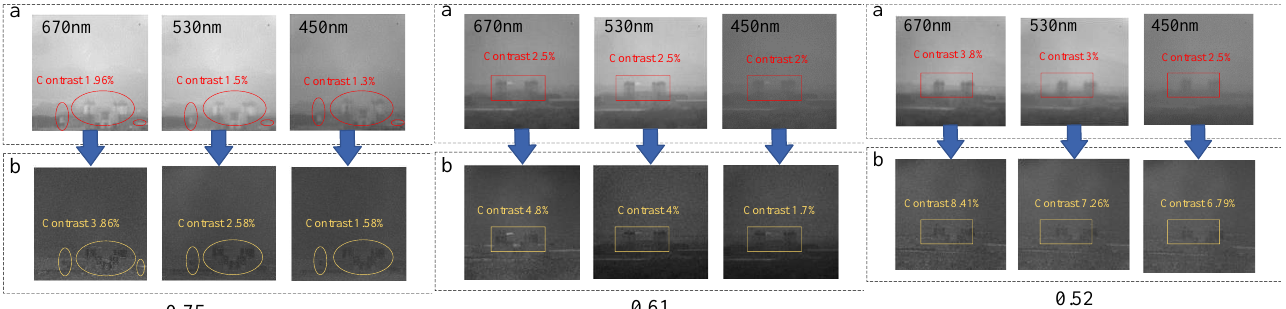
Figure 12. Multi-band images with different optical thicknesses ( a ). Intensity image; ( b ). Polarization image. each band gets blurrier, yet the polarization image produced may still reveal the edge con- tour with greater clarity. Since the difference between the visible target and the